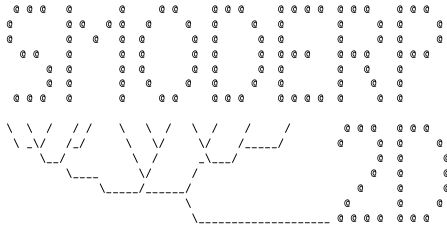
Figure 1. ASCII-art SMODERP2D project logo